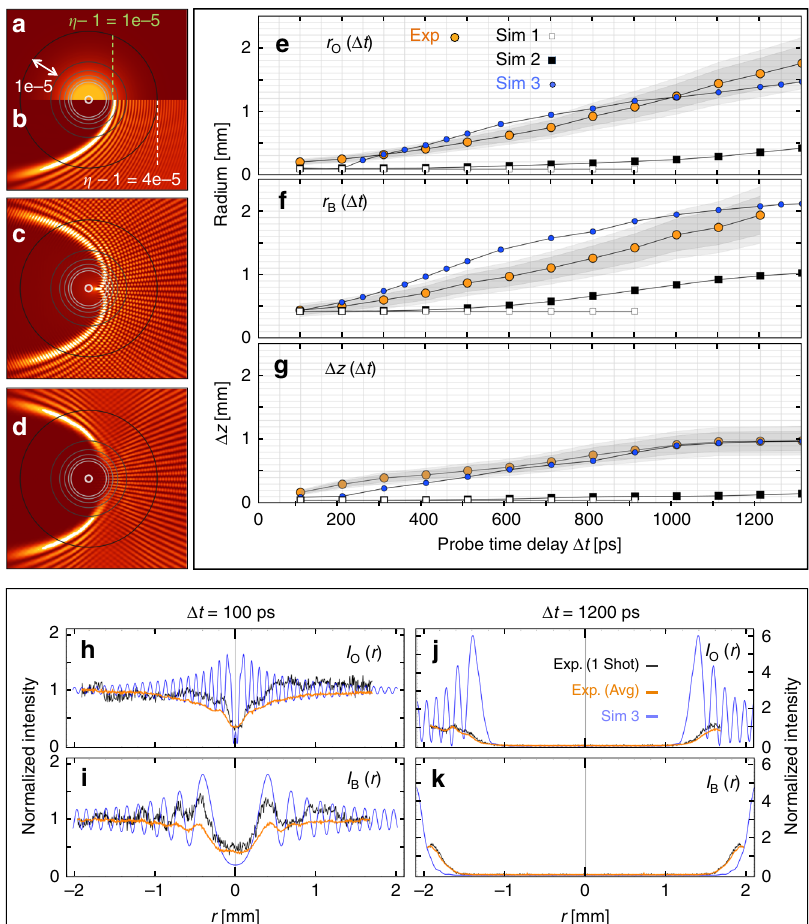
Fig. 2 Comparison of probe image features with simulation results. a – d Electromagnetic simulations showing how probe intensity pro fi le evolves through plasma column to detector: a Typical refractive index cross-section η ( r ) of plasma column at object plane O, with column axis tilted at 8 mrad to page normal from left (back) to right (front); black circles: index contours in Δ η = 10 − 5 increments; b radial intensity pro fi le of probe, propagating normally out of page, at O, showing light penetration to η − 1 = 10 − 5 contour, parabolic shadow and surrounding interference fringes; c corresponding probe pro fi le after ideal imaging to detector, showing axial caustic and orthogonal interference fringes acquired in passing through remainder of plasma column. d Corresponding probe pro fi le after non-ideal imaging to detector, showing re-shaping of vertex region due to partial blockage of imaging lens shown in Fig. 1b. e – g Plots of e r O ( Δ t ), f r B ( Δ t ), and g Δ z ( Δ t ) from measured probe images (orange- fi lled circle data points), showing 1 σ (dark gray) and 2 σ (light gray band) variations over 30 shots, and from the three theoretical models corresponding to Fig. 1d – f: no impact ionization (open gray squares), ground state impact ionization ( fi lled black squares), impact excitation + impact ionization ( fi lled blue circles). h – k Lineouts of measured single shot (black curves) and 30-shot averaged (orange curves) normalized probe intensity at positions O ( h , j ) and B ( i , k ) for Δ t = 100 ps ( h , i ) and 1200 ps ( j , k ), compared to Simulation 3 calculations (blue dashed black curve) and multi-shot averaged (Fig. 1c) data. Probe propagation simulations showed that fringe spacing was sensitive to θ , but agreed well with observed fringe spacing for θ = 8.0 ±